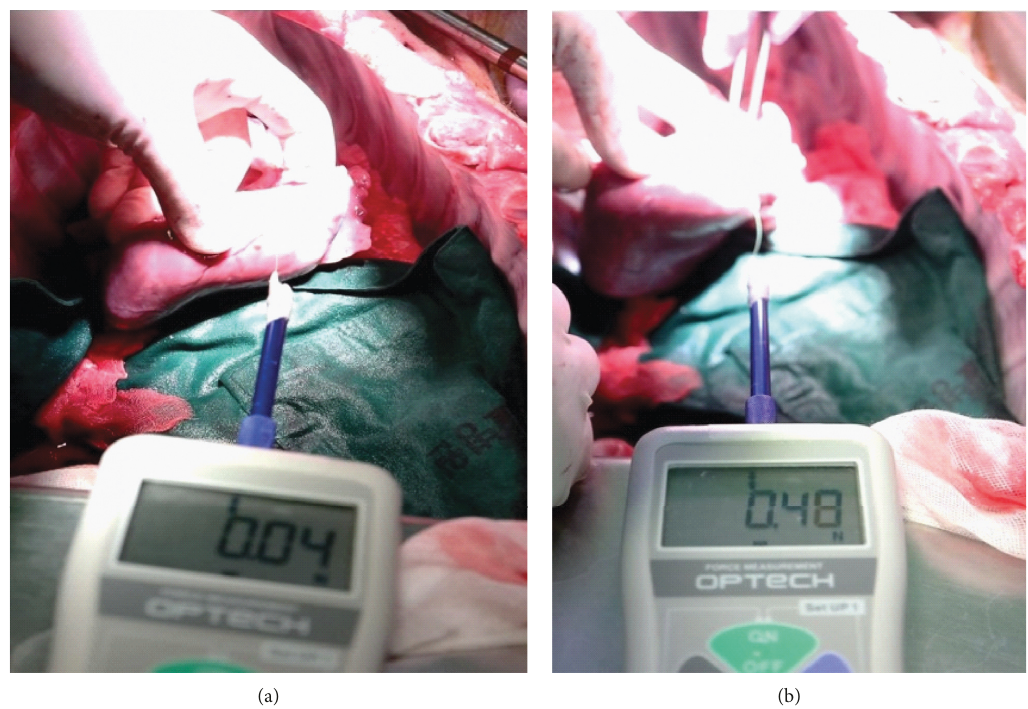
Figure 3: Procedural steps and wire positioning results. (a) The guidewire naturally passing through the myocardium with a force of 0.04N (4.08 gf). (b) The guidewire requiring a force of 0.45 N (45.89 gf) to traverse the vessel wall and penetrate the